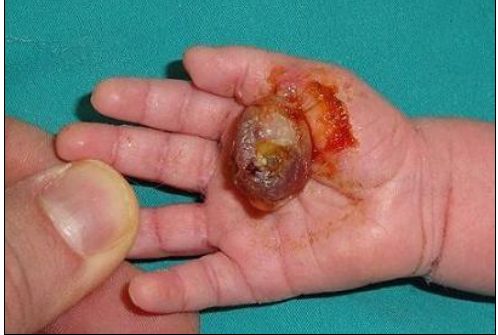
Figure 1: Lesion on palmer aspect of right